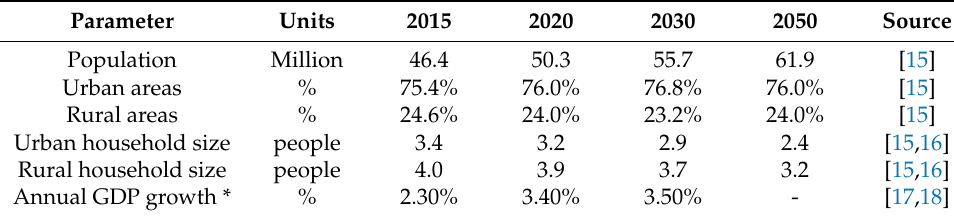
Table 1. Macroeconomic and demographic